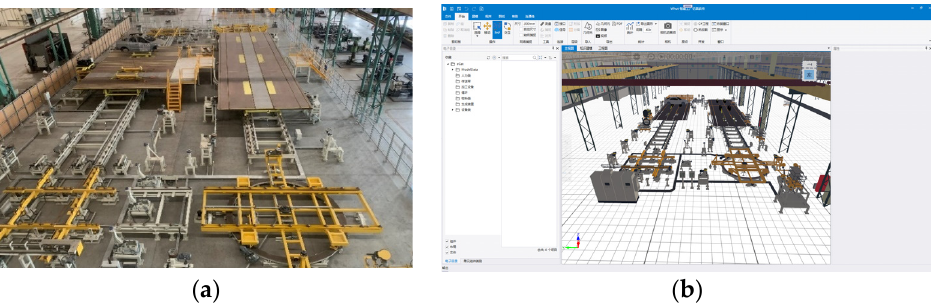
Figure 7. Multifunctional lift-and-slide experimental line: ( a ) physical entities ( b ) digital twin models.